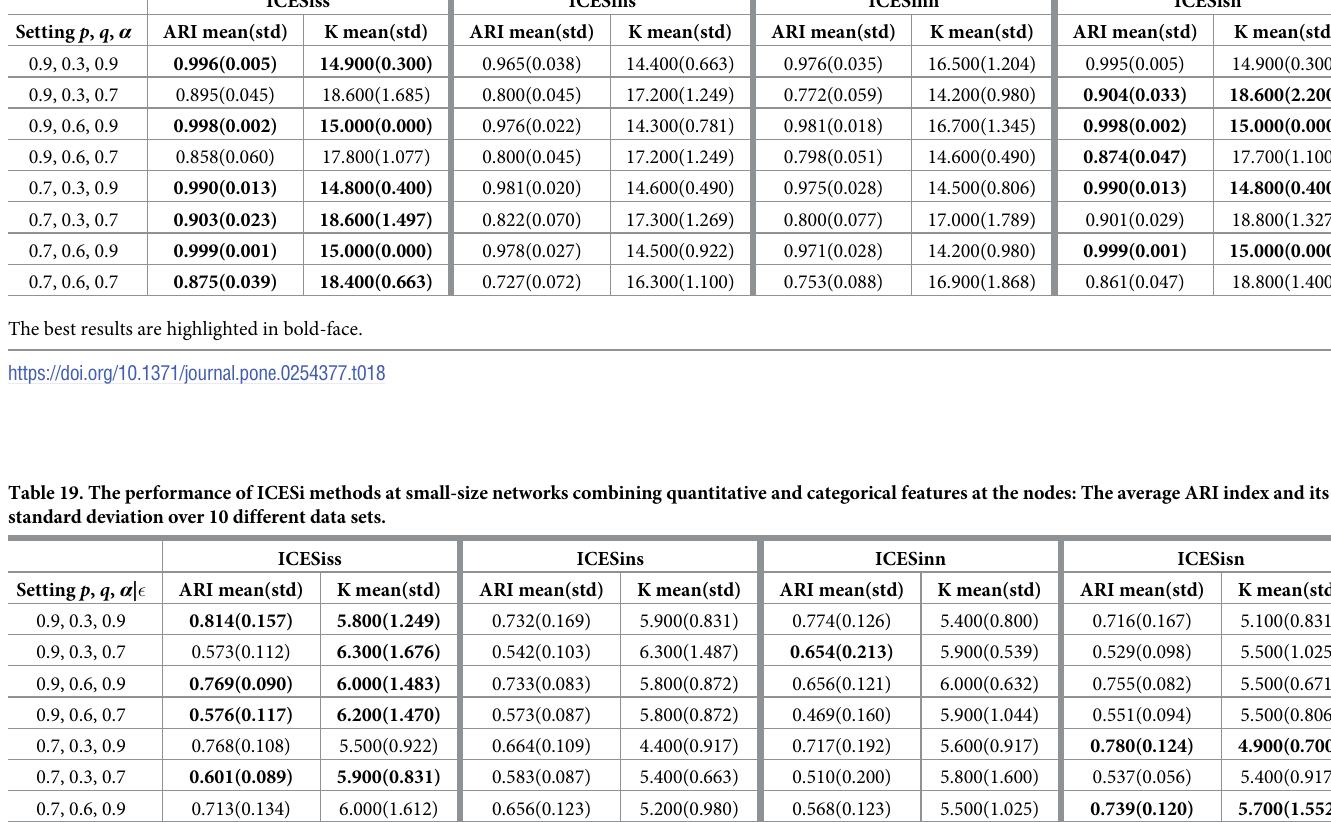
Table 18. The performance of ICESi methods at medium-size networks with categorical features at the nodes; with selected data pre-processing for each algorithm: The average ARI index and its standard deviation over 10 different data sets. ICESiss Setting p , q , α 0.9, 0.3, 0.9